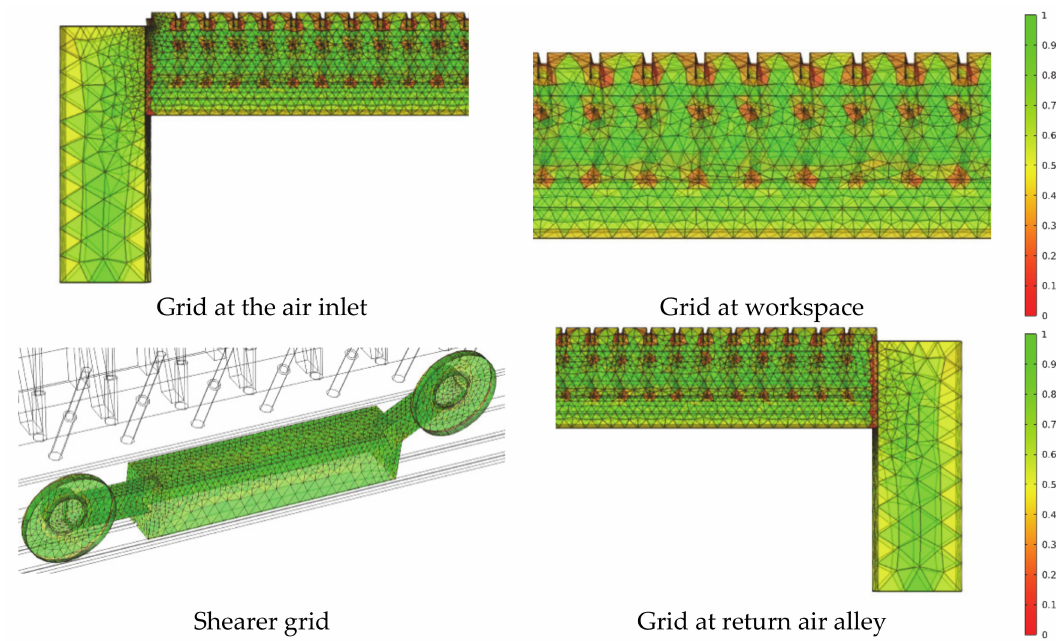
Figure 2. Partial meshing of the geometric model.